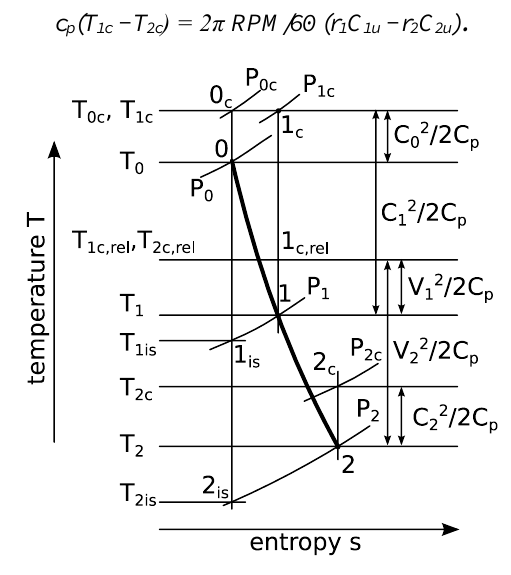
Fig. 4. T-s diagram of a reaction